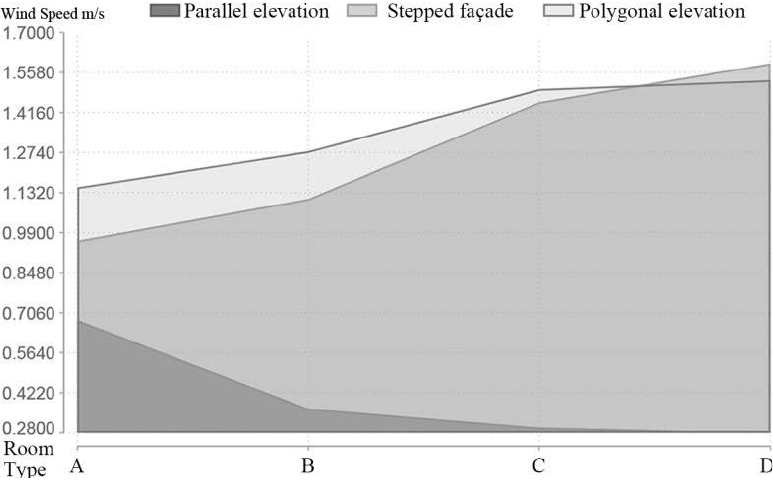
Figure 16. Average wind speed on the windward side of the front and rear rows of buildings with different façade grouping forms.